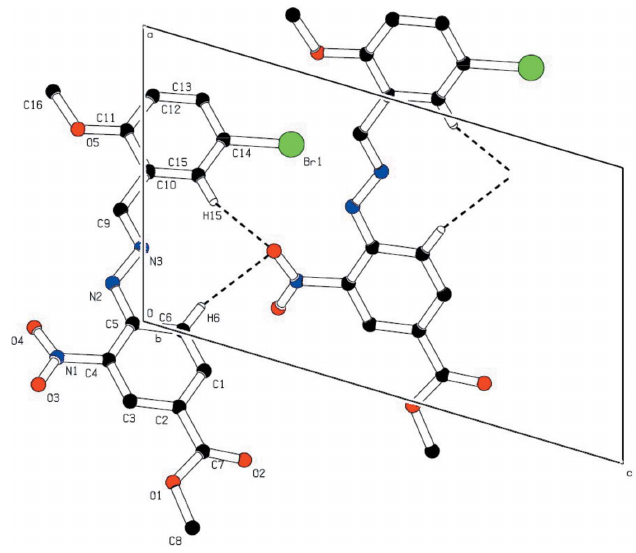
Figure 2 Aview of part of the crystal structure of the title compound, showing